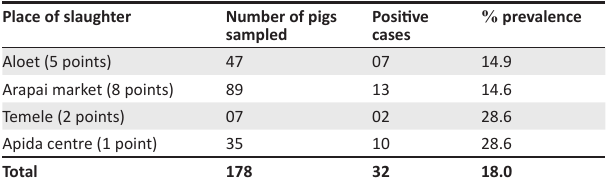
TABLE 1: Occurrence of porcine cysticercosis amongst free-range pigs delivered to various slaughter places in Arapai subcounty, Soroti district, eastern Uganda. Place of